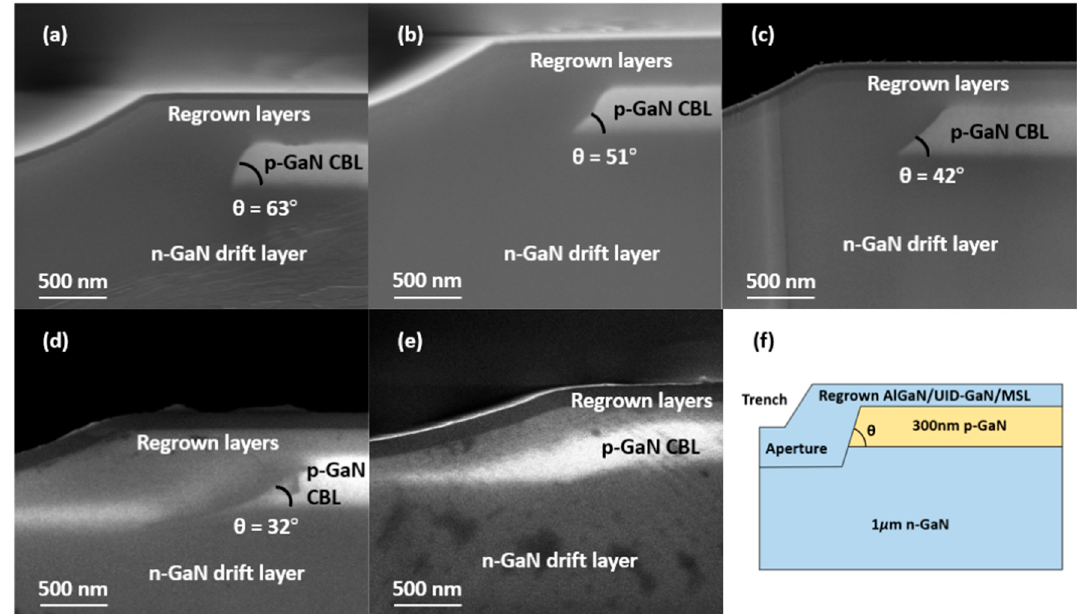
Figure 3. SEM cross-sectional pro fi les of the partial trench region with ( a ) 100 nm MSL at 750 °C, ( b ) 50 nm MSL at 750 °C, ( c ) 10 nm MSL at 750 °C, ( d ) 100 nm MSL at 800 °C, and ( e ) 10 nm MSL at 800 °C. ( f ) is the schematic of the partial trench region for the SEM images.